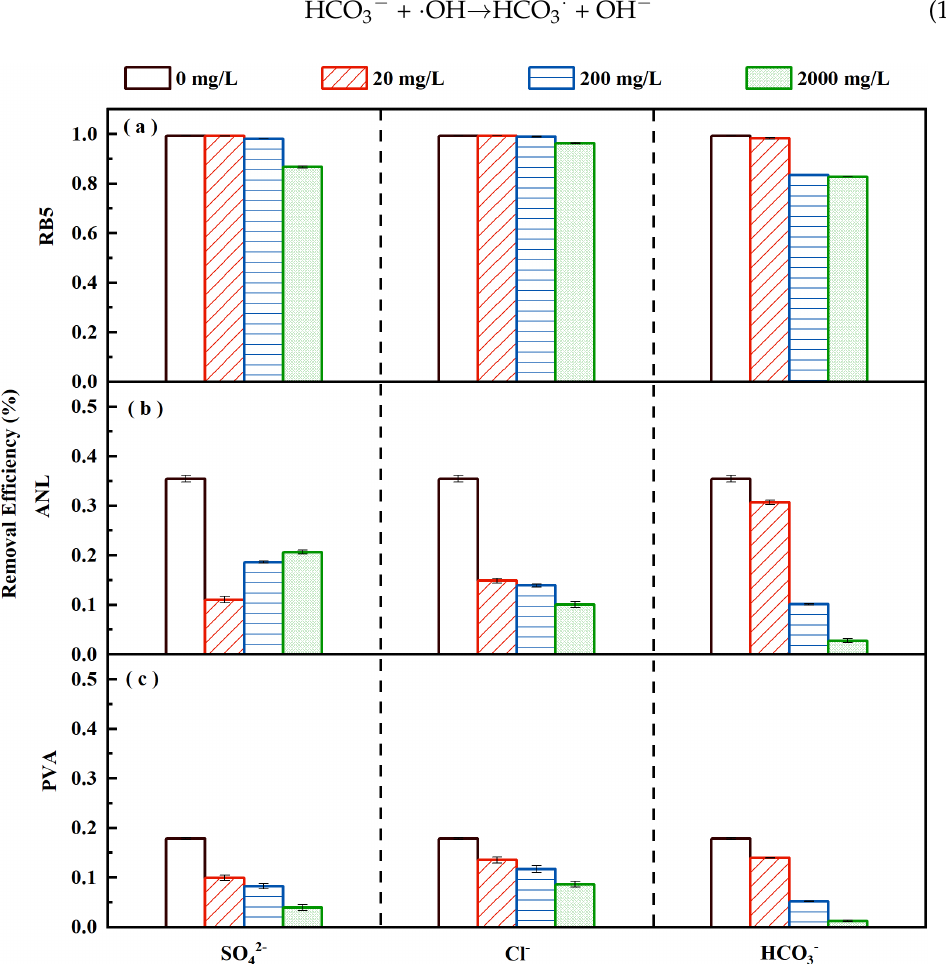
Figure 3. Effect of coexisting SO 4 2− , Cl − , and HCO 3 − on the degradation of ( a ) RB5, ( b ) ANL, and ( c ) PVA in Fe 2+ /PAA/H 2 O 2 system. Conditions: [PAA] = 15 mg/L, [RB5] 0 = 20 mg/L, [PVA] 0 or [ANL] 0 = 10 mg/L, pH = 3.0, T = 21 ± 1 °C, [anion] = 0, 20, 200, and 2000 mg/L.